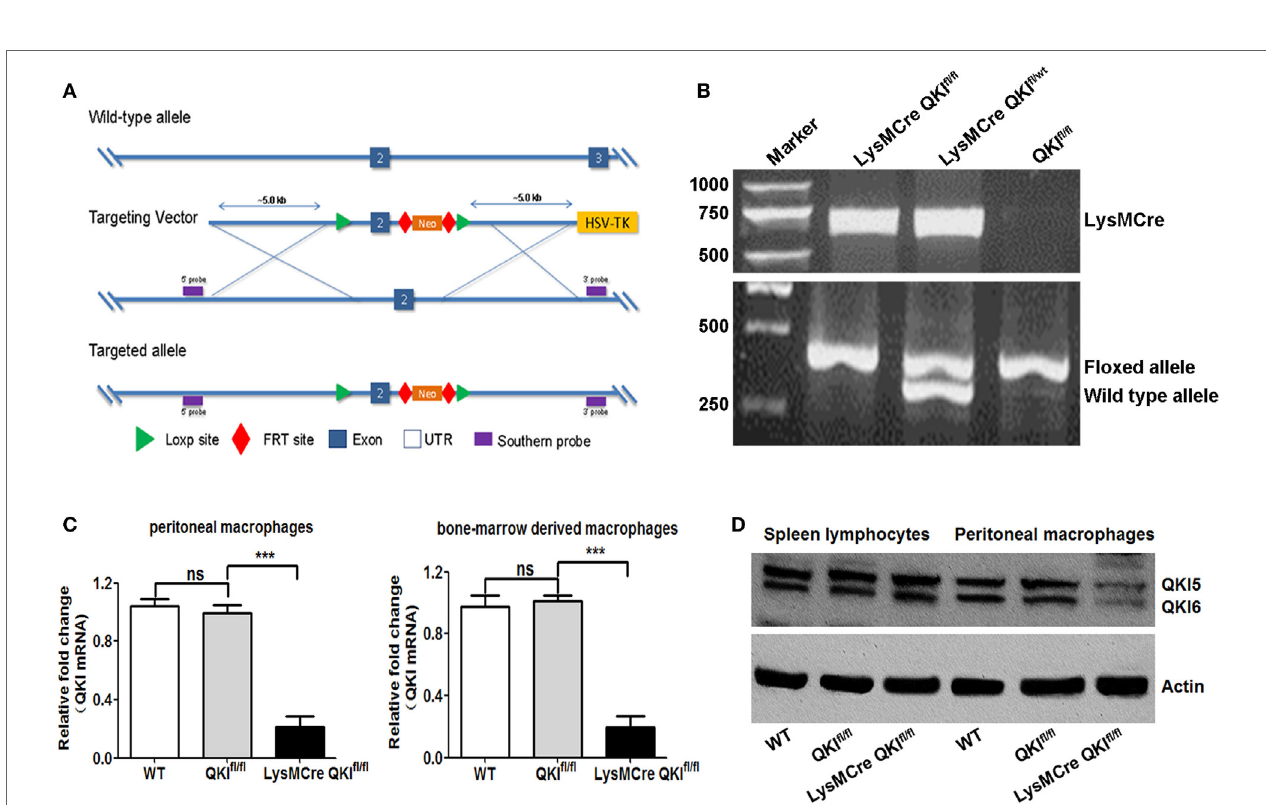
FigUre 5 | Generation and characterization of myeloid-specific quaking (QKI)-deficient mice. (a) The targeting strategy of QKI LoxP mice is shown. (B) Total genomic DNA from mouse tail tissues was isolated and subjected to PCR analysis using a site-specific primer. The 700-bp product indicates the presence of the cre allele. The 410-bp product indicates the presence of the QKI-floxed allele, while the 370-bp product indicates the presence of the wild-type (WT) allele. (c) WT, QKI fl/fl , and LysMCre QKI fl/fl mouse thioglycollate-induced peritoneal macrophages and bone marrow-derived macrophages were analyzed for QKI mRNA expression